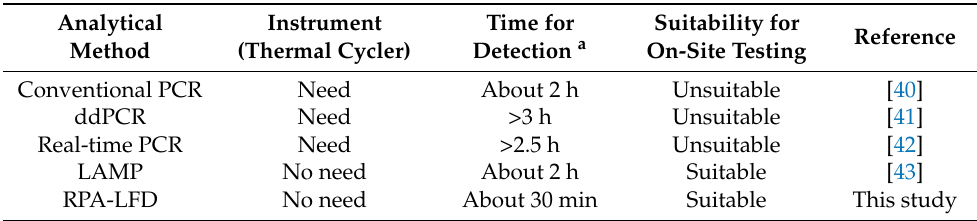
Table 2. Comparison of RPA-LFD with other methods for detection of